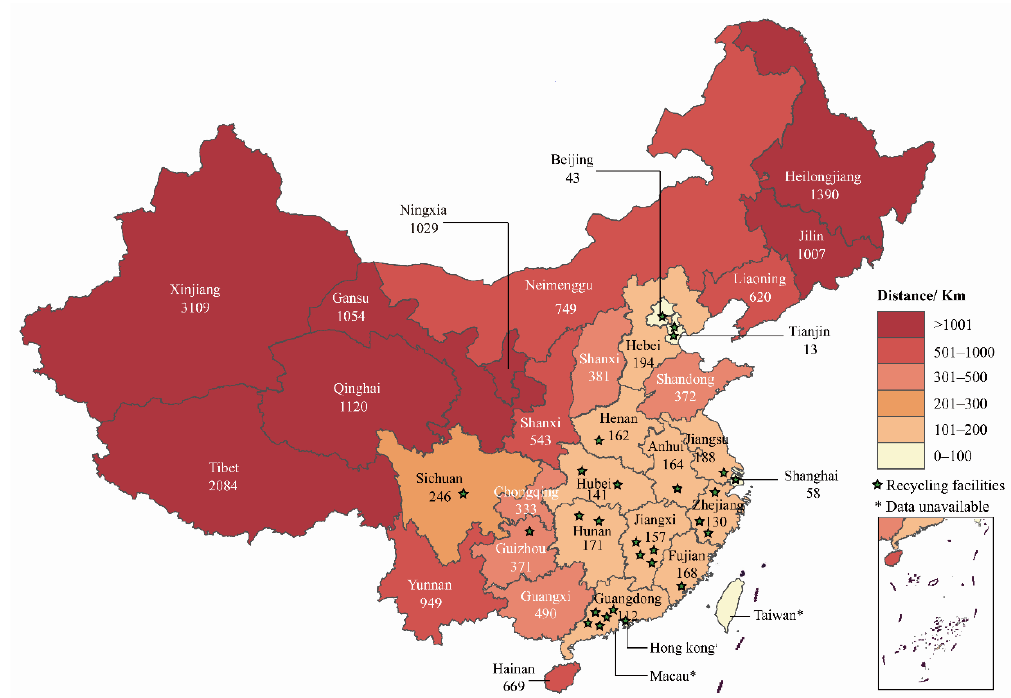
Figure 13. Spatial distribution of the transportation distance of spent EV LIBs from the vehicle dismantling plant to the closest LIB treatment facilities in China. The numbers indicate the average closest transportation distance of spent EV LIBs for each province.